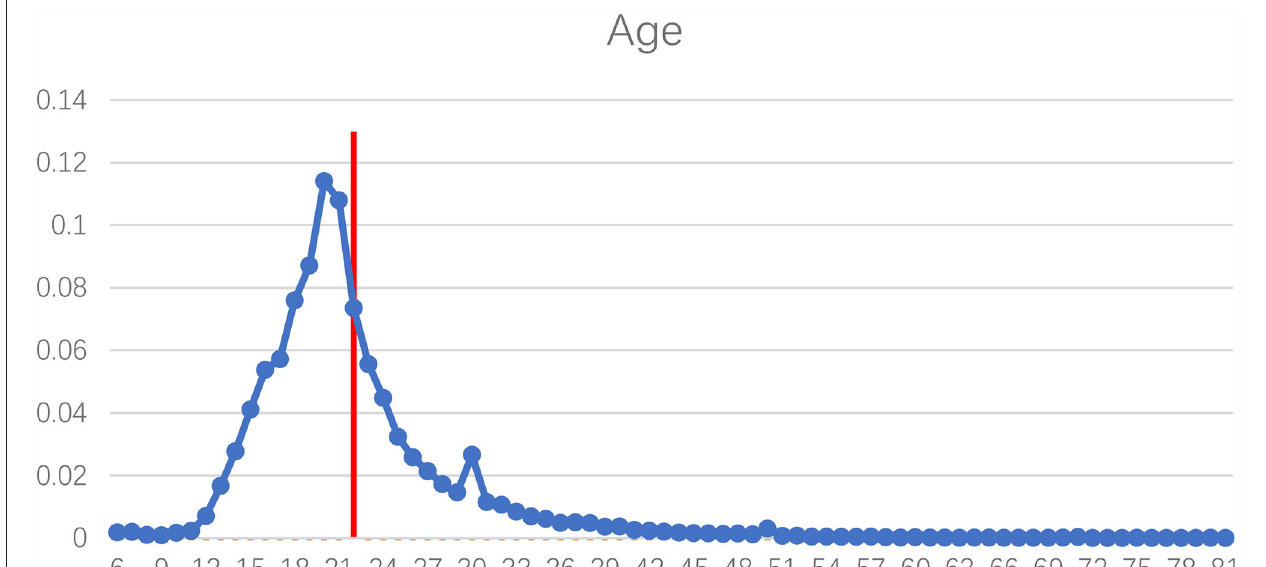
FIGURE 4 | Age distribution of the hashtag “#national mask campaign#”